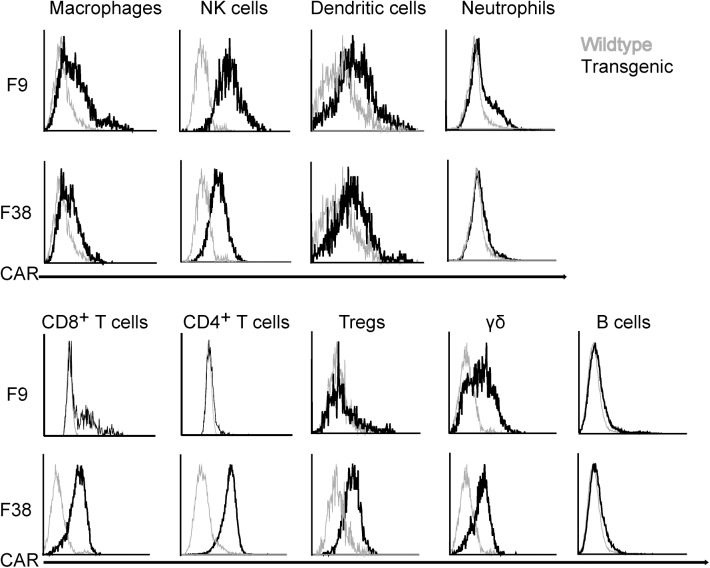
CAR expression is varied between different immune subsets and founders.Splenocytes from vav-CAR (black line) and WT (grey line) mice were stained for surface markers (markers from Fig 4) and CAR expression. Individual immune subsets were gated on and the level of receptor assessed comparative to WT splenocytes. Representative FACS plot shown for each subset.